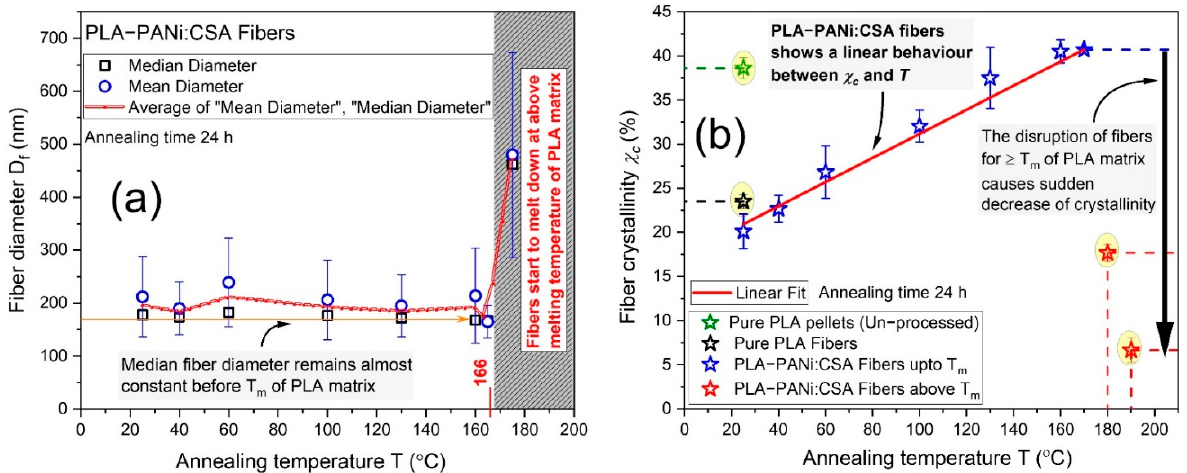
Figure 5. ( a ) shows the diameter analysis of PLA-PANi:CSA fibers at room temperature and 40, 60, 100, 130, 160, 165, and 175 ◦ C, with ϕ PANi ≈ 10%. ( b ) shows the crystallinities (calculated from DSC data) of pure PLA pellets (unprocessed), pure PLA fibers, and PLA-PANi:CSA fibers at room temperature and 40, 60, 100, 130, 160, 170, 180, and 190 ◦ C with ϕ PANi ≈ 10%. Solid red line shows the linear dependence between crystallinity χ c and annealing temperature T for PLA-PANi:CSA fibers.